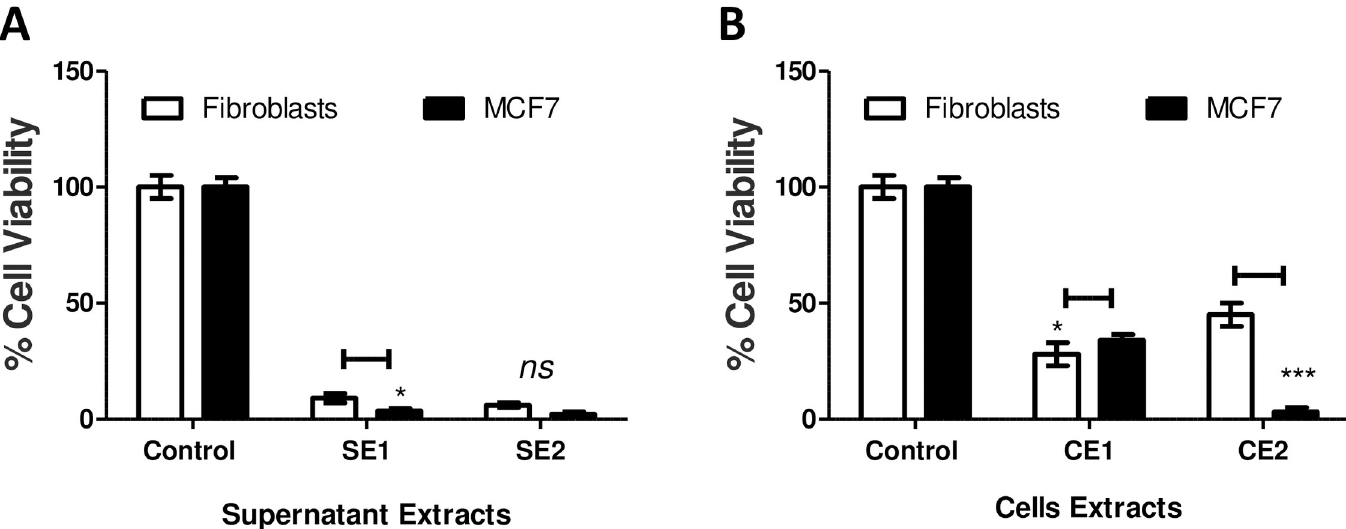
Fig 1. Cytotoxic activities of metabolites extracted from mammalian cell cultures. (A) Cytotoxic activities of metabolites extracted from supernatants collected from F180 (SE1) and MCF7 (SE2) cell cultures. (B) Cytotoxic activities of metabolites extracted from F180 (CE1) and MCF7 (CE2) cells separated from mammalian cell cultures. The cells were seeded in 96-well plate at a concentration of 5 × 10 4 cells/ well in 100 μ l culture medium followed by incubation with the samples overnight prior to MTT assay. The data was analyzed using two-way ANOVA and statistical significance was calculated with Bonferroni’s multiple comparisons test and significance level were indicated by asterisks ( � , P < 0.05; �� , P < 0.01: ��� , P < 0.001; ���� , P < 0.0001). The data display the mean of the percentage of the survival rate of mammalian cells ± SEM of 6